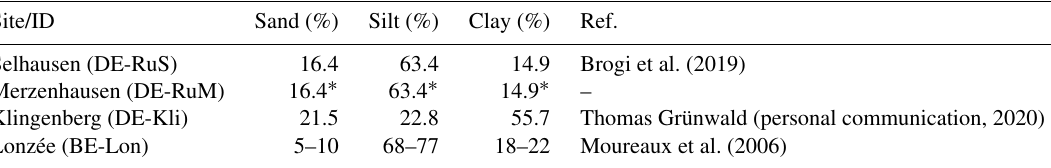
Table A3. Textural fractions (sand, silt, and clay percentages) for the ICOS and TERENO cropland study sites averaged for the upper soil layers (up to 50cm) with corresponding